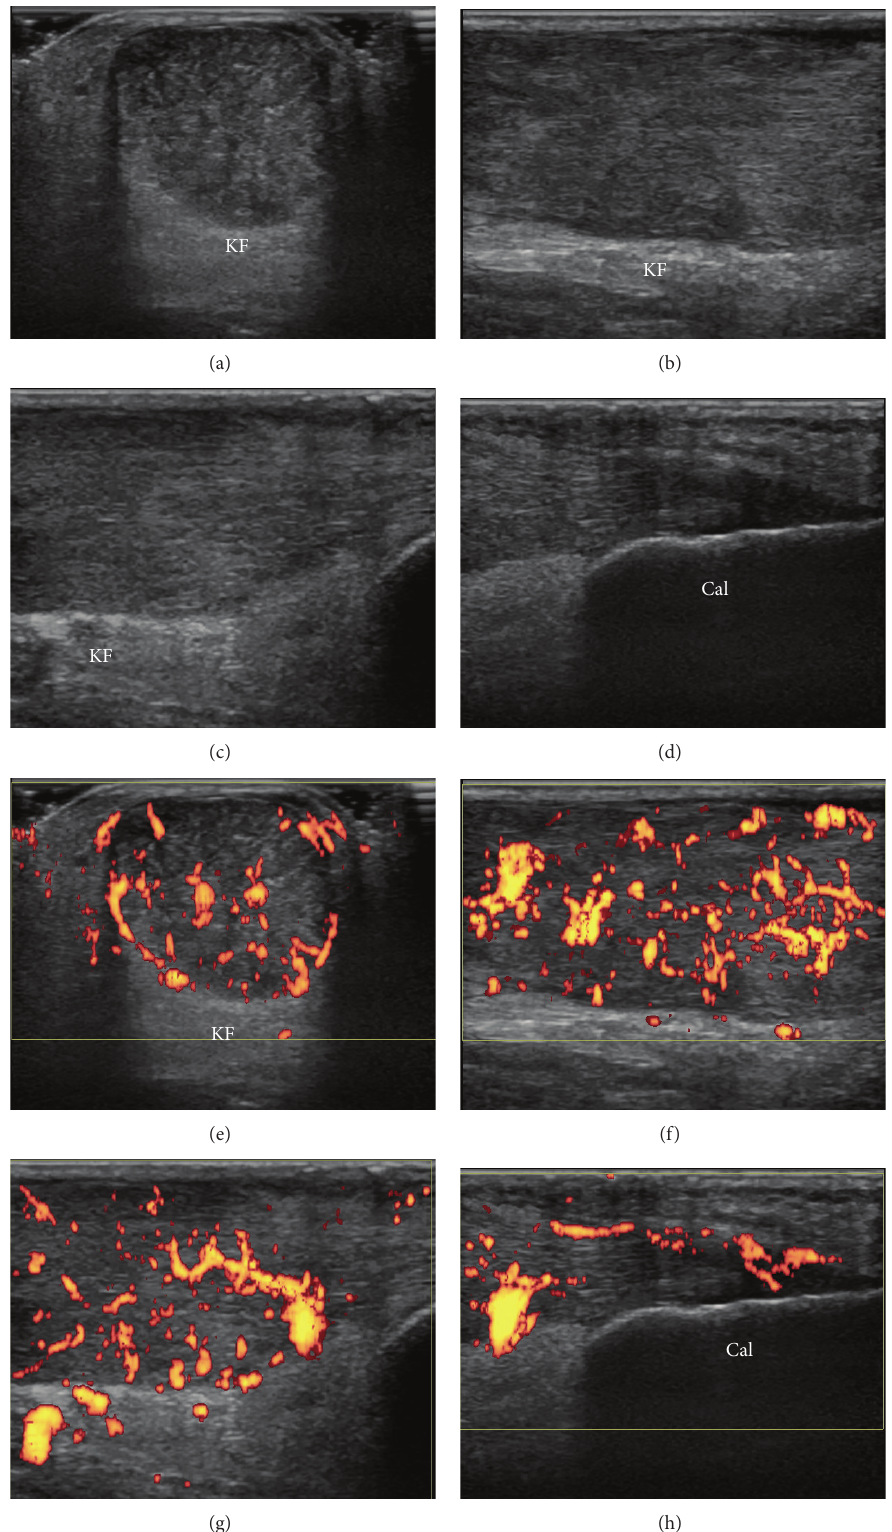
Figure 2: Ultrasound findings of the Achilles tendon. Gray-scale ((a)–(d)) and power Doppler ((e)–(h)) ultrasonograms of the right Achilles tendon (AT). Transverse scans at the midportion ((a), (e)) and longitudinal scans at the midportion ((b), (f)), at the level of retrocalcaneal bursa ((c), (g)), and at the insertion into the calcaneal bone ((d), (h)) of the right AT. Similar findings were also observed in the left AT (not shown). KF Kager’s fat pad, Cal